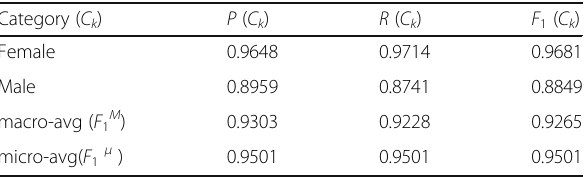
Table 1 Performance measure with unique IDs decomposition using cross validation =